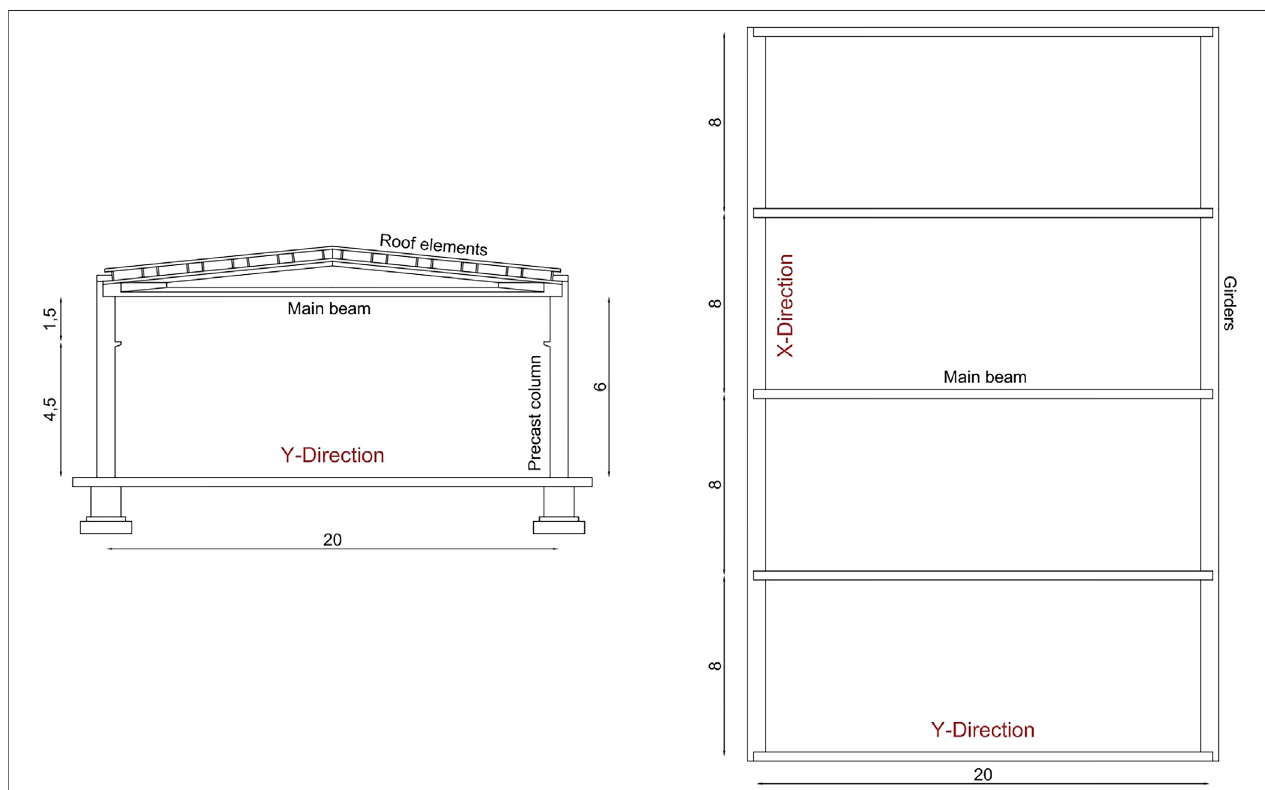
FIGURE 10 | Schematic transverse frame (left) and plan view (right) .